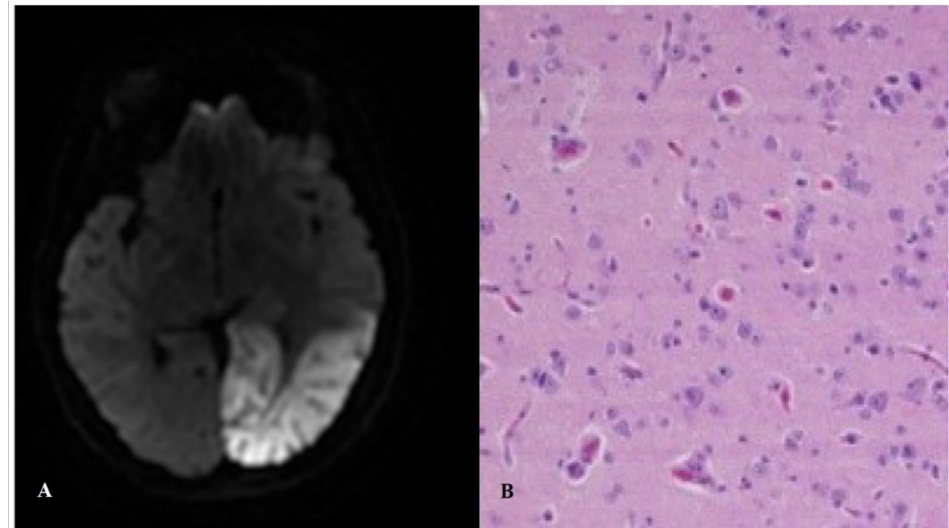
Figure 2. Stroke-like lesion. Magnetic resonance ( A ) and histopathological ( B ) findings. Panel B shows a brain biopsy from a MELAS (mitochondrial encephalopathy with lactic acidosis and stroke-like episodes) patient, with “red neurons” and spongiosis with reactive astrocytosis in the cortex and the white matter